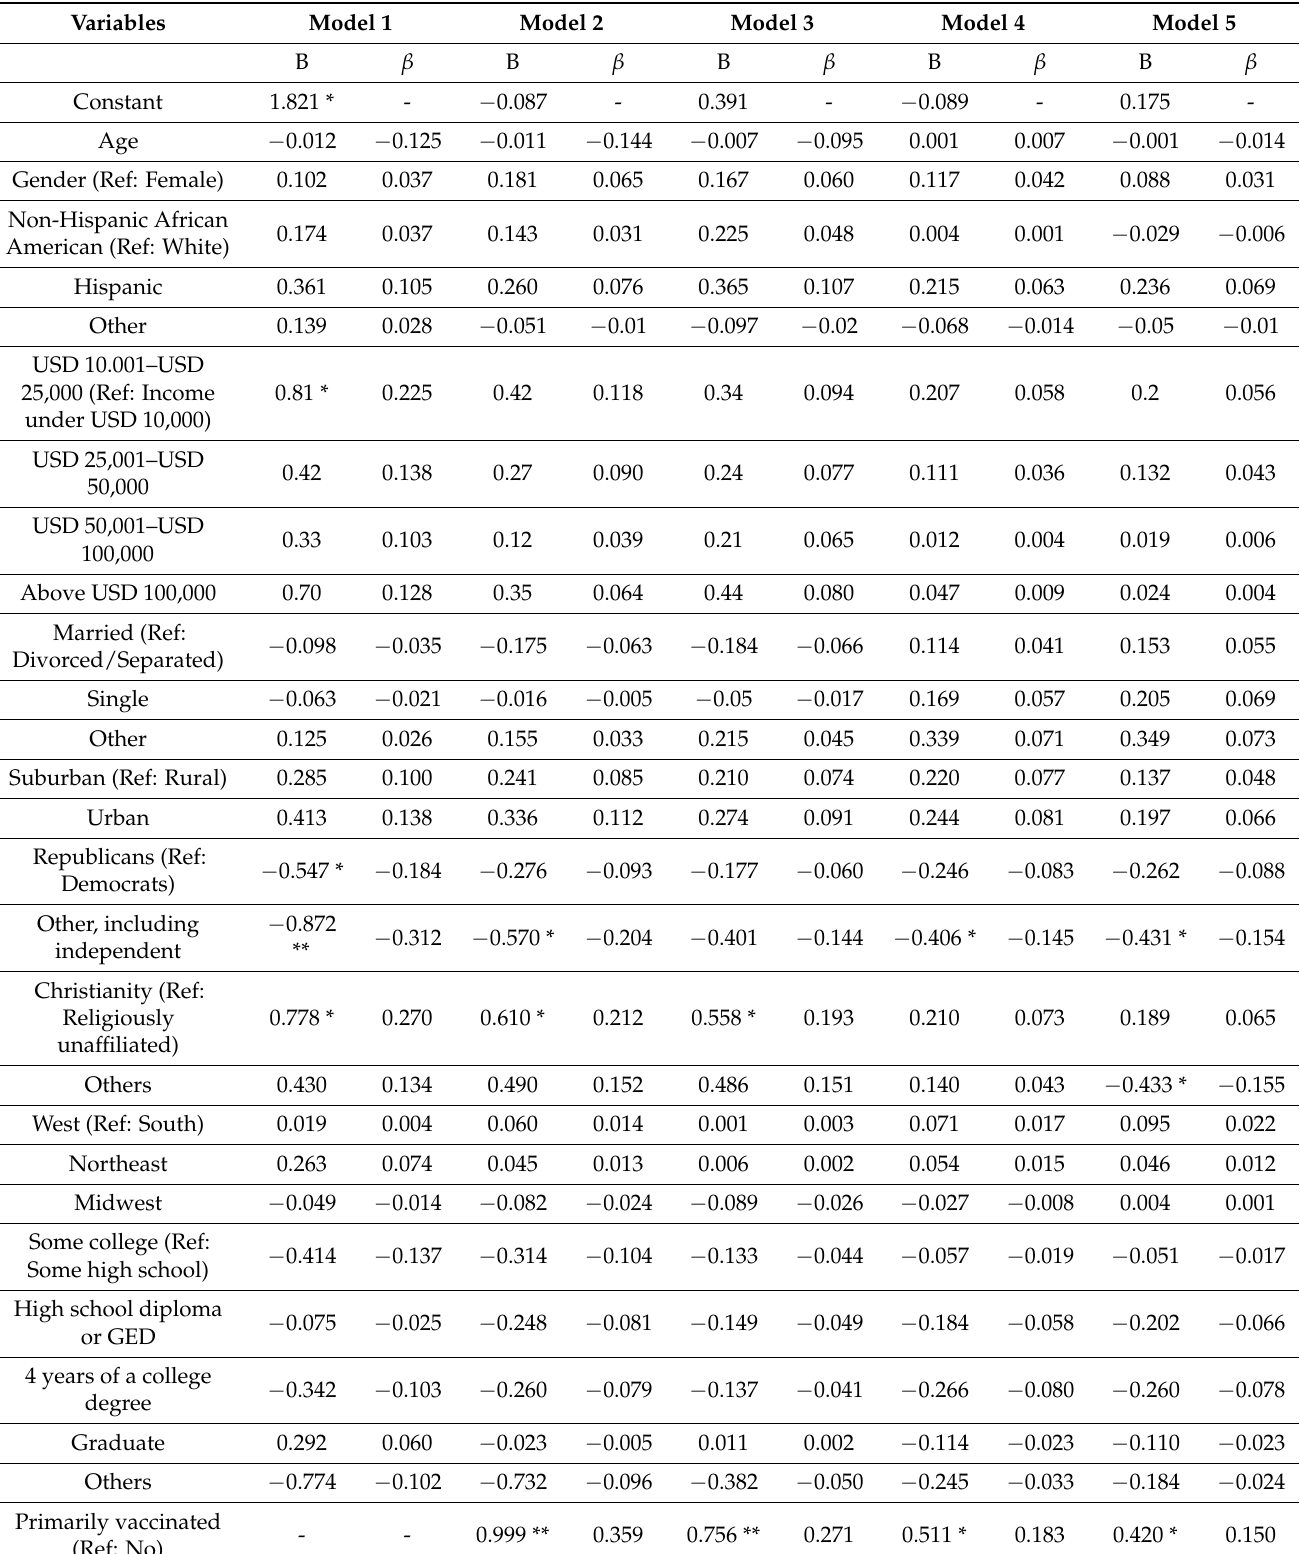
Table 6. Hierarchical multiple regression (HRM) predicting the intention of COVID-19 booster dose acceptability among hesitant respondents ( n =